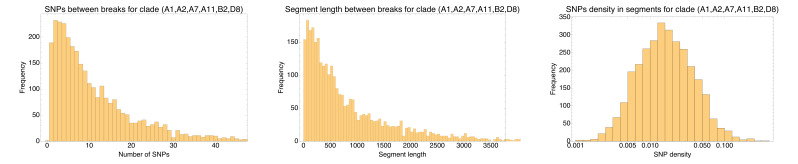
Left: Histogram of the number of consecutive SNPs before an inconsistency in the core genome alignment of the sextet of strains (A1,A2,A7,A11,B2,D8) of phylogroup B2.Note that the vertical axis corresponds to the number of segments with the corresponding number of consecutive SNPs. Middle: Histogram of the length of segments without phylogeny breaks. Right: Histogram of the SNP density across the segments that are consistent with a single phylogeny (shown on a logarithmic axis). Note that the SNP densities vary by two orders of magnitude.